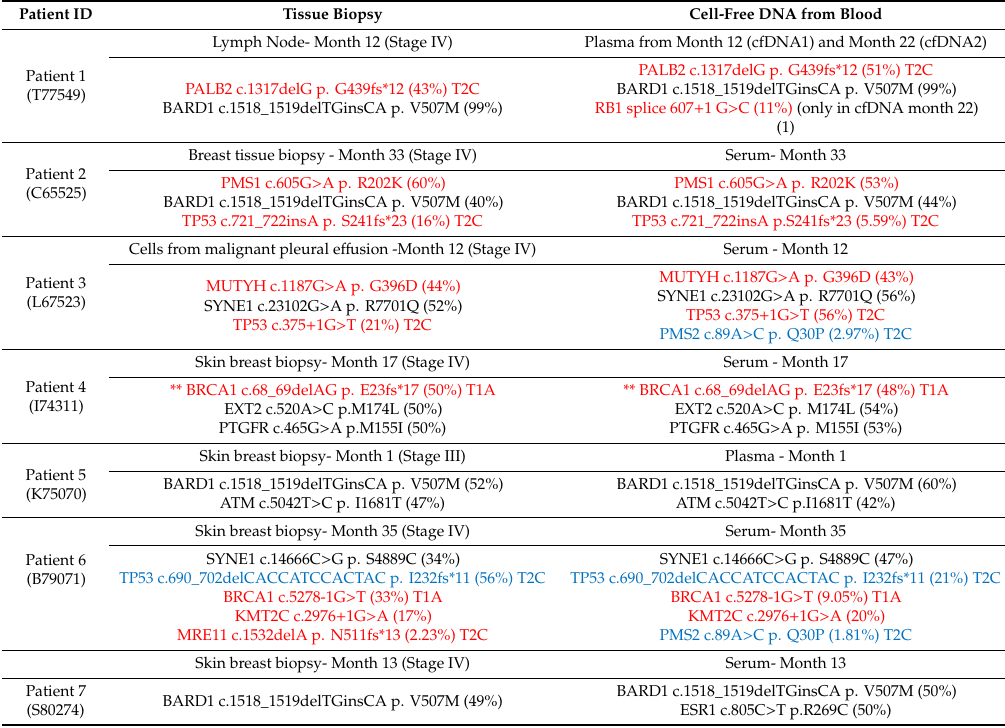
Table 1. Clinically relevant variants in triple negative IBC. Variants were classified as pathogenic (in red), likely pathogenic (in blue) or variants of uncertain significance (in black). Variants were also classified according to its actionability: T1A indicates strong clinical significance; T2C indicates potential clinical significance and FDA-approved therapies for di ff erent tumor types or investigational therapies. For each variant, its allele fraction (AF) is indicated in parenthesis. The samples used to study genomic variants, collection time from disease onset, and stage of the disease at the time of sample collection are indicated. (1) For patient 1, cfDNA samples from month 12 (cfDNA1) and month 22 (cfDNA2) were studied and PALB2 and BARD1 variants were detected in both, but the RB1 mutation was only detected in cfDNA from month 22. All the patients were pre-treated except patient 5 (month 1) and patient 19 at month 8 that did not receive any treatment at those times. (**) In patients 4 and 9, the BRCA variants were confirmed to be of germline